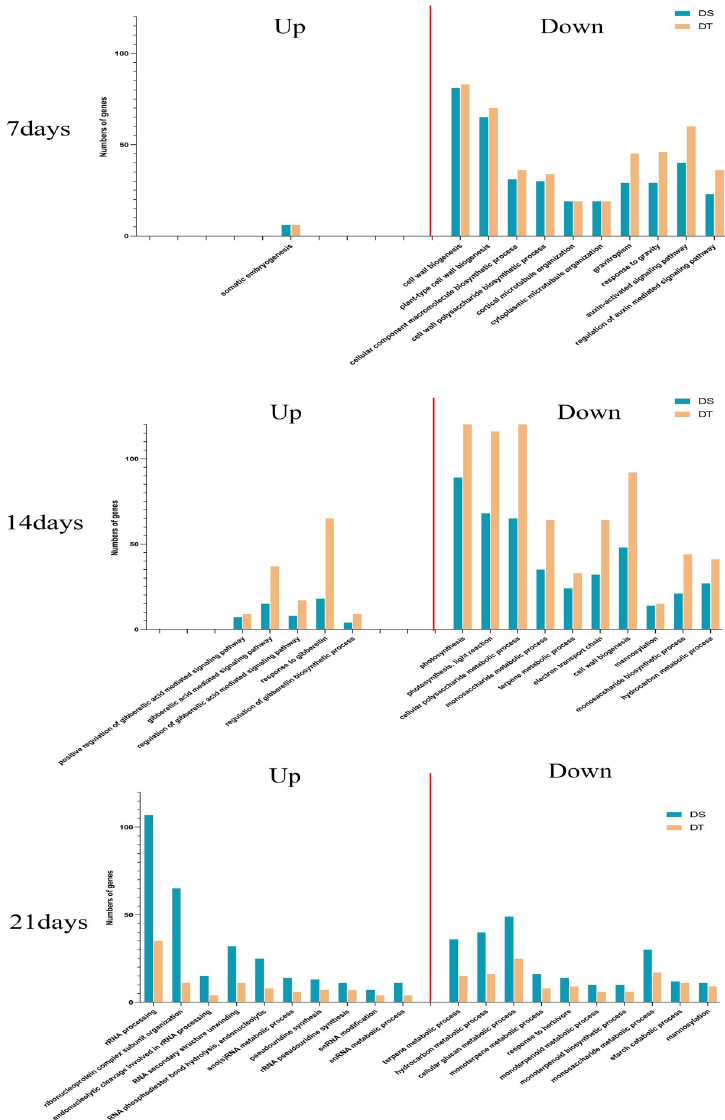
Fig 4. GO analysis for significant DEGs. Graphical representation of number of DEGs enriched in common biological process GO-terms in DS comparative to DT at all three-time intervals.